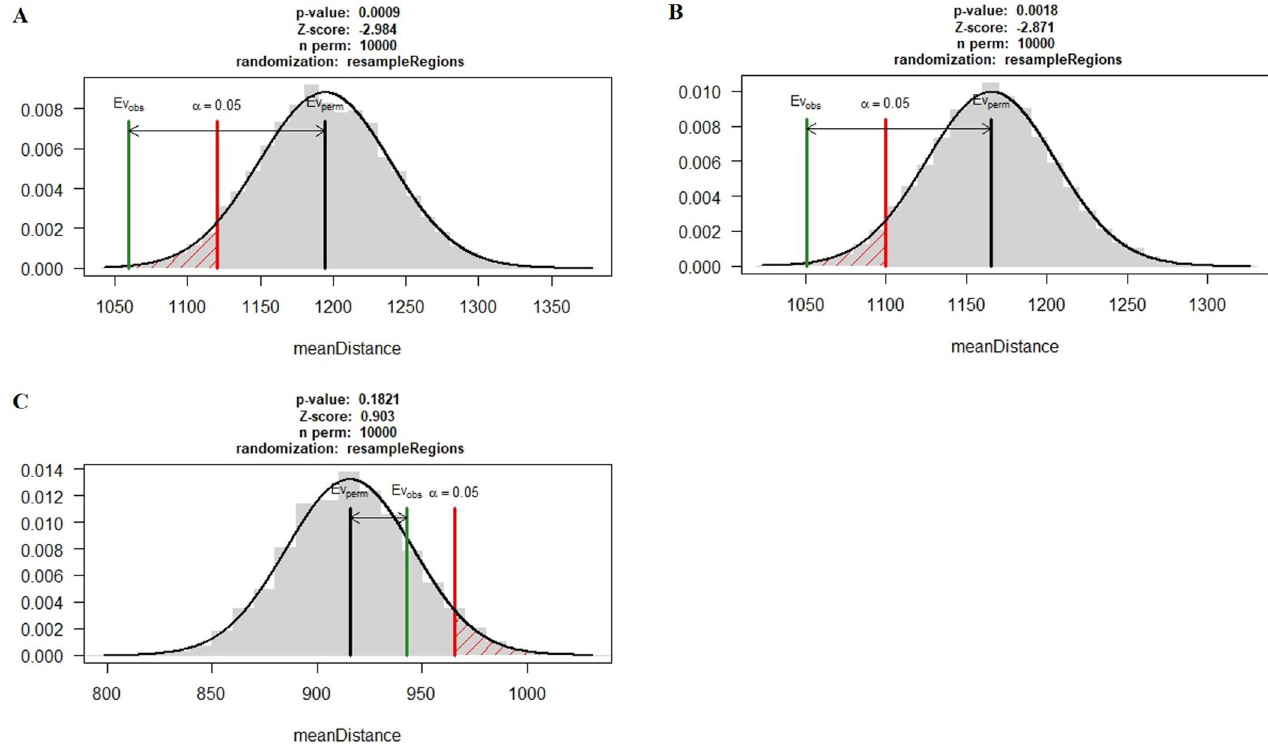
Fig 6. Association between the genomic repeats and effector gene in pathotypes. Black bar represents the mean distance of random sampling from the repeats, red bar indicates the significance limit and green bar represent the mean of observed distance for the effector genes from the repeats. A) Pst110S119, B) Pst78S84, and C)